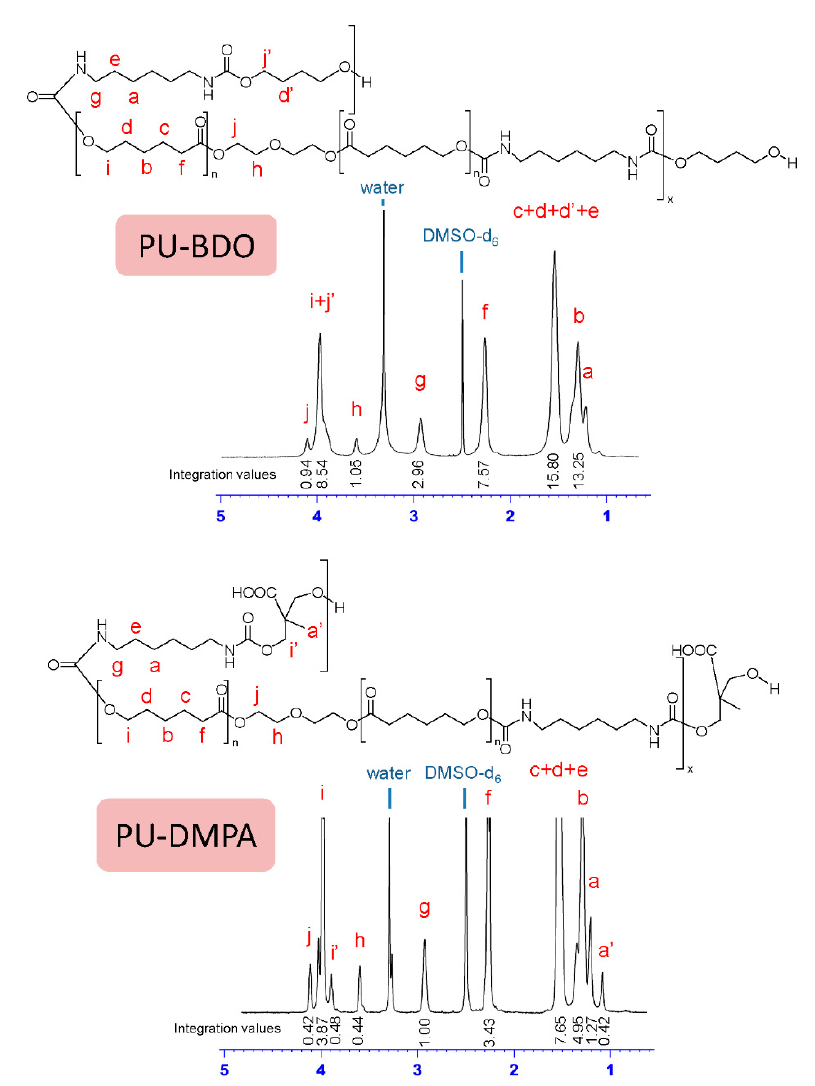
Figure 2. 1 H-NMR of the PU-BDO ( top ) and the PU-DMPA ( bottom ).